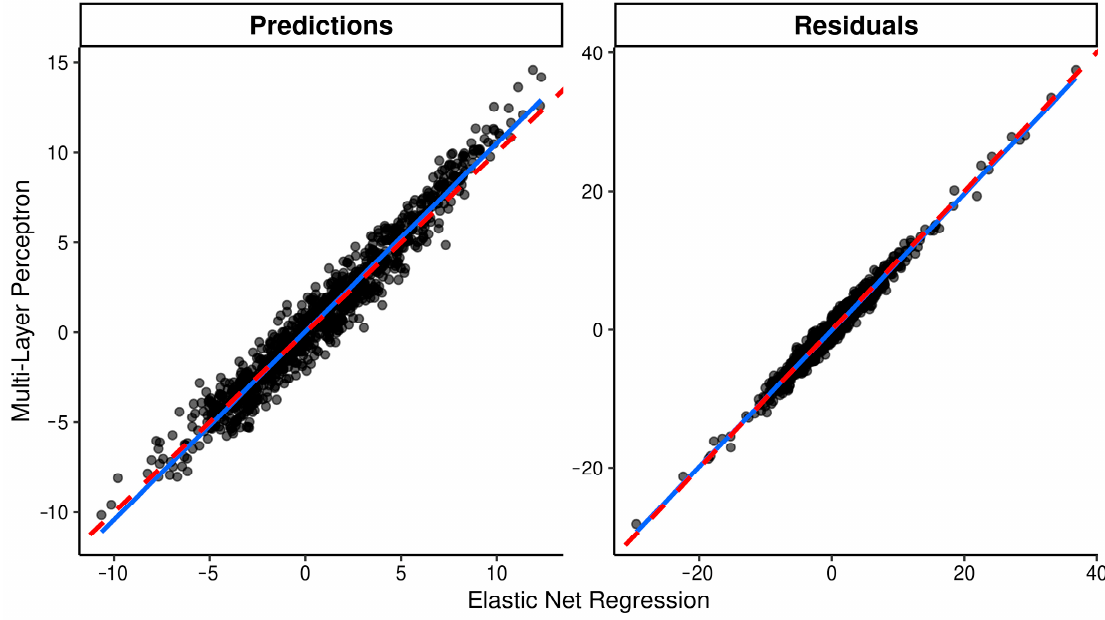
Figure 3. Comparison between elastic net regression and multilayer perceptron models. In this figure, we show the correlation between elastic net regression and multilayer perceptron models’ predictions and residuals. Each dot represents the value in one individual of the test set, the red-dashed lines represents the ideal correlation and the blue lines represent the real correlation in the data. High correlations suggest a certain degree of similitude between models.